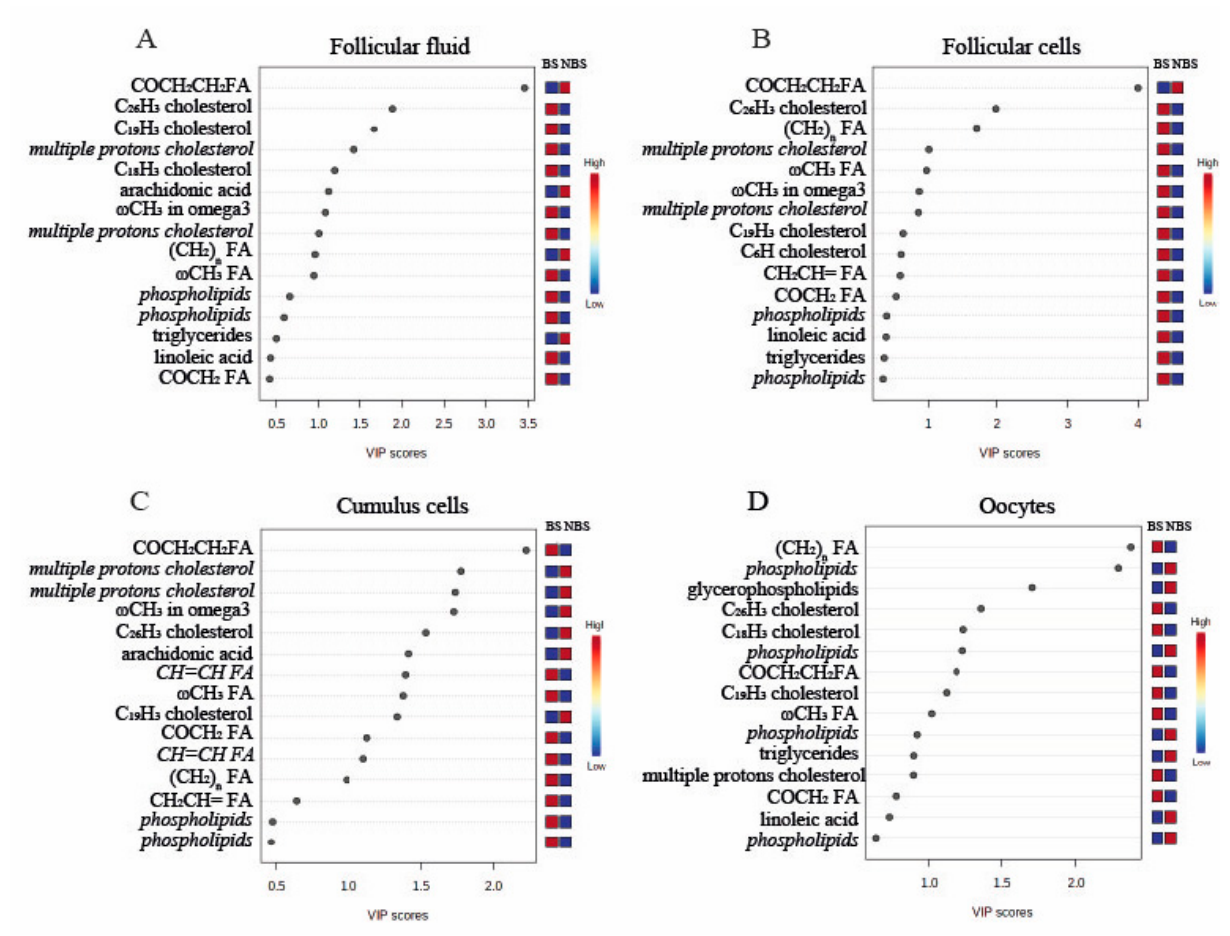
Figure 2. Variable importance in projection (VIP) showing the 15 proton signals corresponding to metabolites with the highest variations between the breeding (BS) and non-breeding (NBS) seasons in: ( A ) follicular fluid; ( B ) follicular cells; ( C ) cumulus cells; and ( D ) oocytes. Metabolites with more than one proton present in the VIP plot are represented in italics.